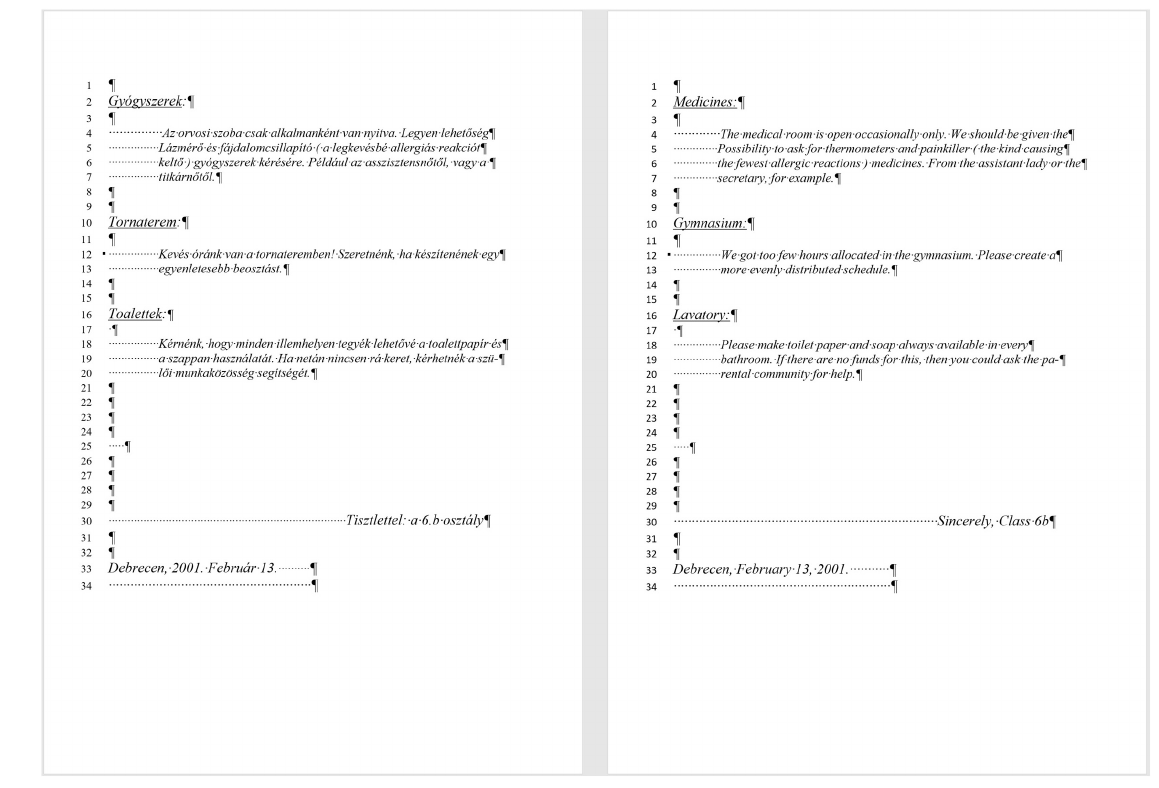
FIGURE1 The original Hungarian document (left) and an English translation (right) , with the non-printing characters shown. Line numbers are not visible in the original document, they are presented here to better describe the structure of the document and refer to its